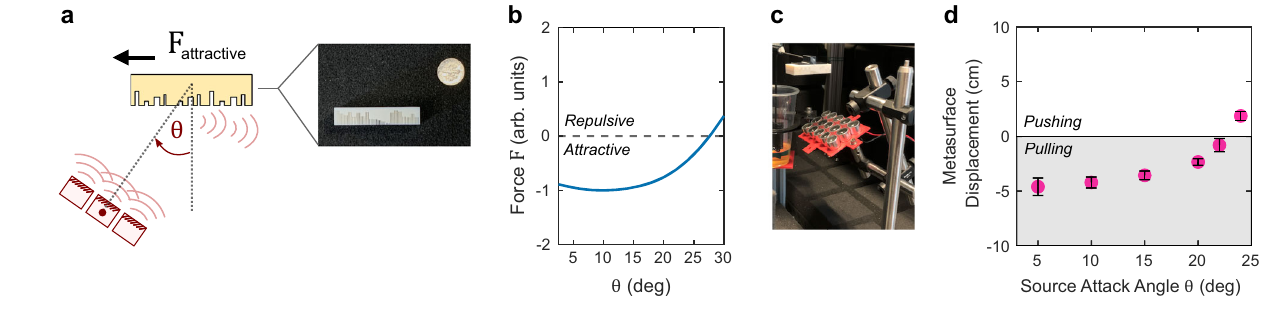
Fig. 4 | Metasurface attractive forces: concept and demonstration. a Shown is the con fi guration of a metasurface designed to experience a force that attracts it toward the radiation source. Right: fabricated metasurface (a dime is shown for scale). b Lateral force as a function of the source attack angle. Negative values denote attractive force.The force isextracted fromthe simulation andnormalized